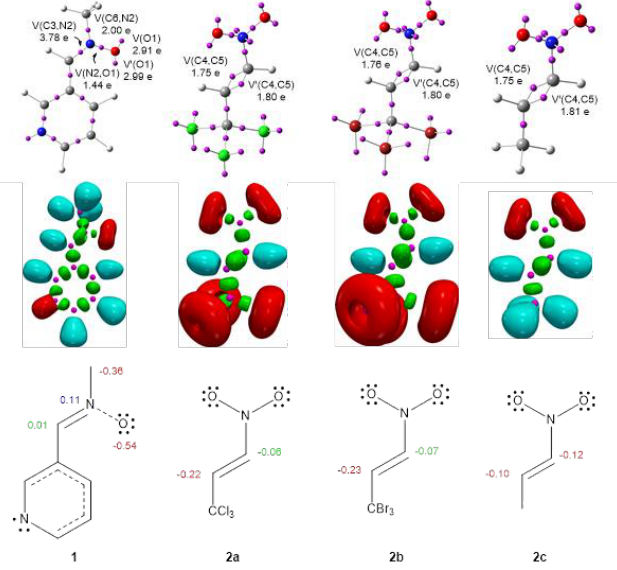
Figure 1. ωB97X-D/6-311G(d) ELF basin attractor positions together with the most relevant valence basin populations, ELF localization domains represented at an isosurface value of ELF = 0.75, and ELF-based Lewis-like structures together with natural atomic charges, for 1-nitropropenes 2a–c and nitrone 1. Valence basin populations and natural atomic charges are given as the average number of electrons, e. Positive charges are colored blue, neutral green, and negative red.